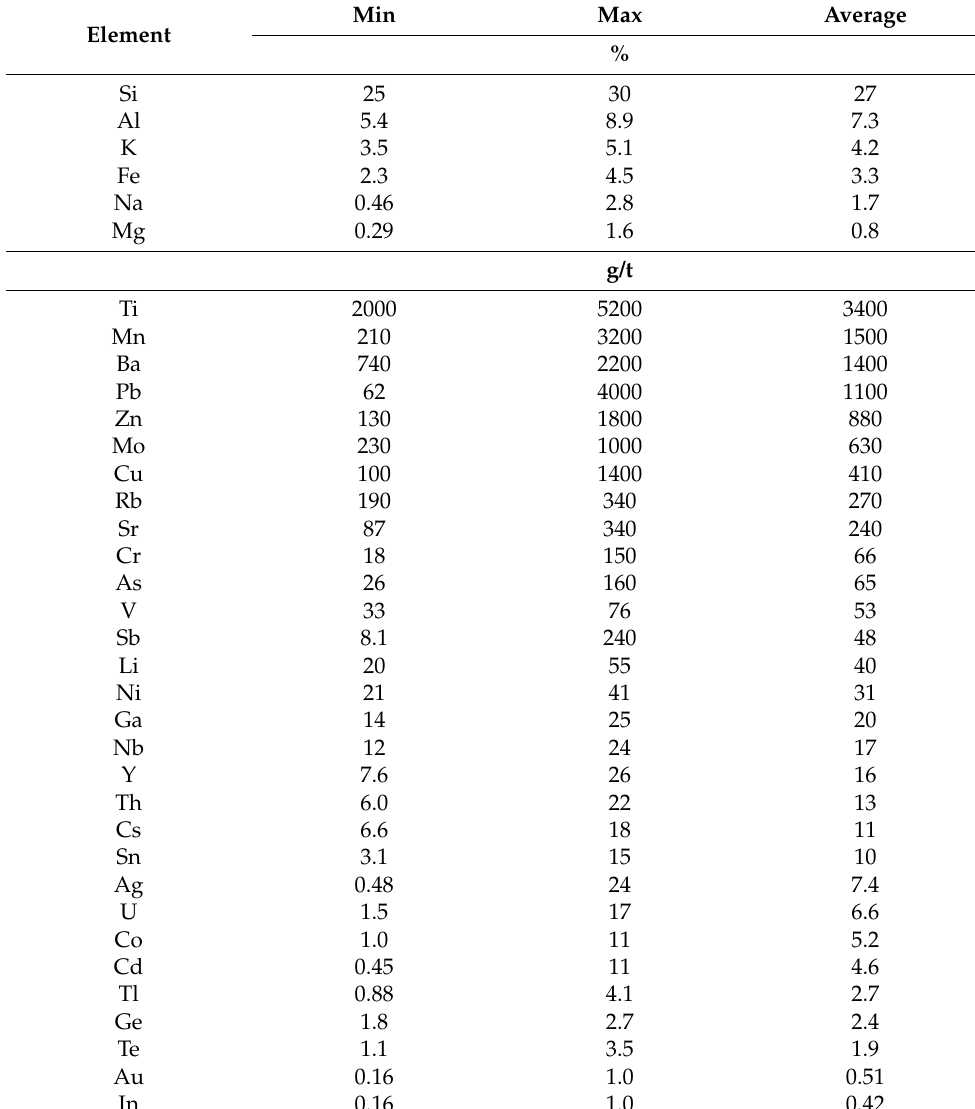
Table 1. The element composition of the Shahtama